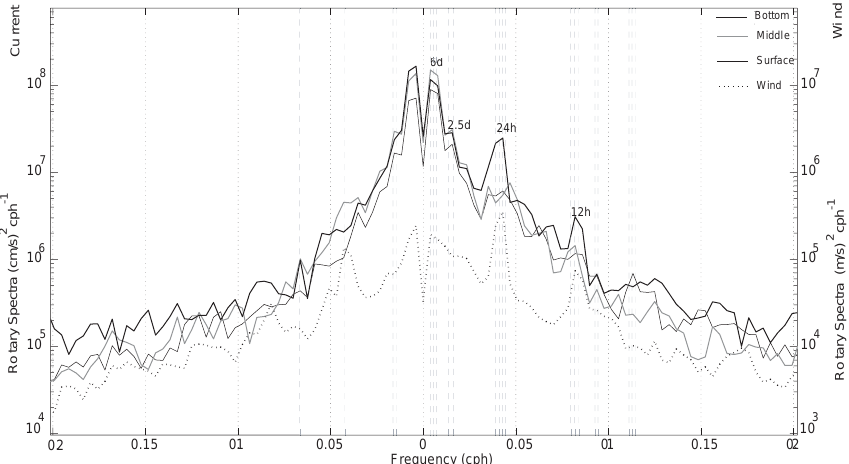
Fig. 9. Two-sided rotary spectrum of hourly filtered current components at three layers (surface, middle and bottom layers which have been shown as thick, dotted and thin lines, respectively) and wind components (bold dotted line) for whole recording period during August and September 2003.